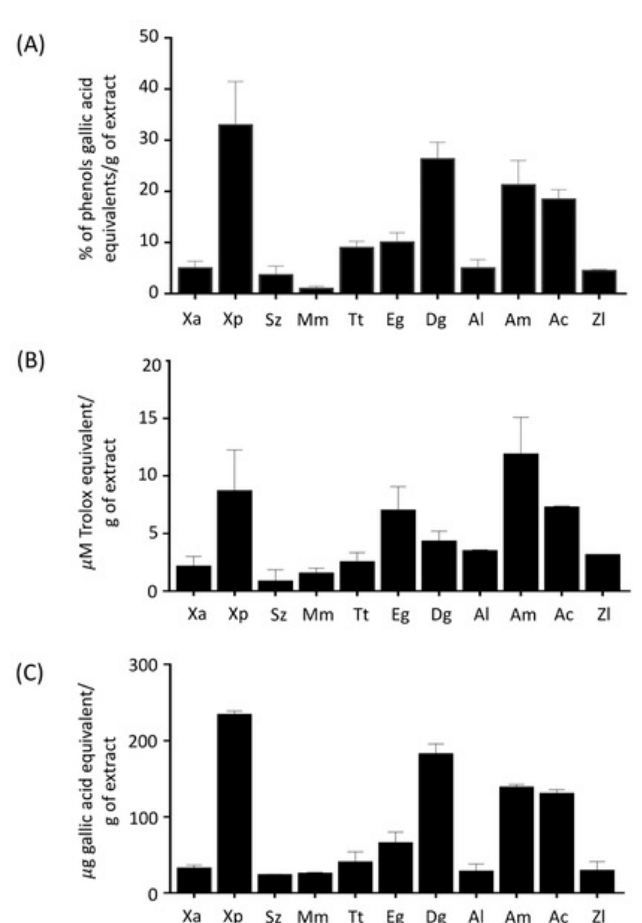
Figure 3. Antioxidant properties of spice extracts in HepG2 cells. Antioxidant capacity of the extracts was evaluated by ( A ) phenol content quantification (data are expressed as % of phenols gallic acid equivalents / g of extract), ( B ) oxygen radical absorbance capacity (ORAC) (data are expressed as µ M Trolox equivalent / g extract), and ( C ) ferric-reducing antioxidant power (FRAP) assays (data are expressed as µ g of gallic acid equivalent / g of extract). Di ff erent letters (a, b, c, d) refer to significant di ff erences among values at the 5% probability threshold (Waller–Duncan test). Abbreviations: Xylopia aethiopica (Xa), Xylopia parviflora (Xp), Scorodophloeus zenkeri (Sz), Monodora myristica (Mm), Tetrapleura tetraptera (Tt), Echinops giganteus (Eg), Afrostyrax lepidophyllus (Al), Dichrostachys glomerata (Dg), Aframomum melegueta (Am), Aframomum citratum (Ac) and Zanthoxylum leprieurii (Zl).